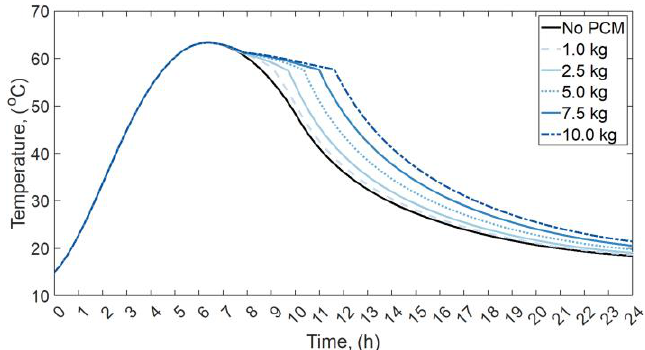
Figure 17. Water temperature in the SS with different masses of PCM — Case 3.